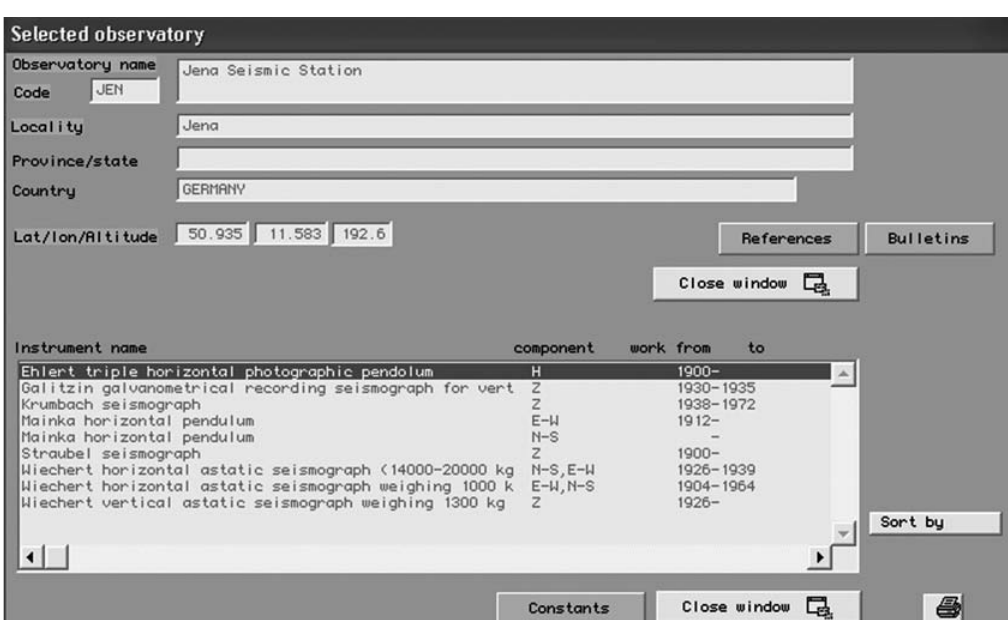
Fig. 3. Observatories file, example of record. The following are indicated: name, international code, location, province or region, country, geographical coordinates and quota. The button «Bulletins» open the window with the list of all the bulletins present in the data base, relating to the selected observatory (fig. 5). In the lower part of the window there is, only when the data are available, the list of instruments used in the ob- servatory, present in the data base. When available these report, besides the name of the instrument, also the components and the start and end dates of function. With the button ‘Constants’, the window Instrument con- stants is accessed, which allows for the visualisation of all the characteristics of the selected instruments, which in turn allows for access to the consultation window of the constant history of the instrument (fig.